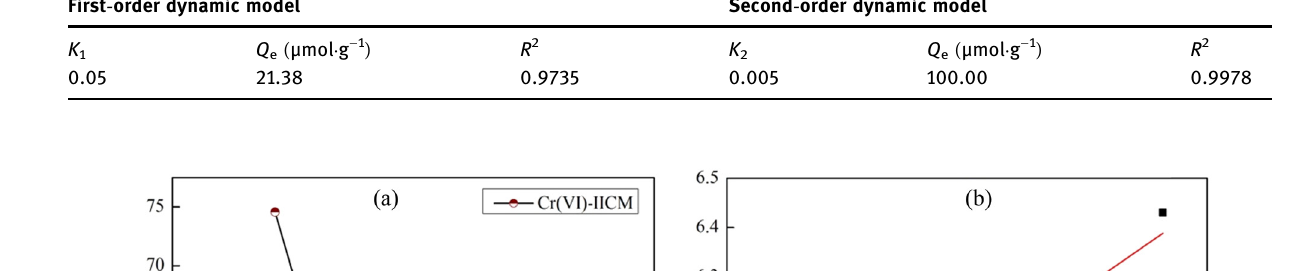
Table 5: Kinetic fi tting parameters of Cr ( VI )- IICM First - order dynamic model